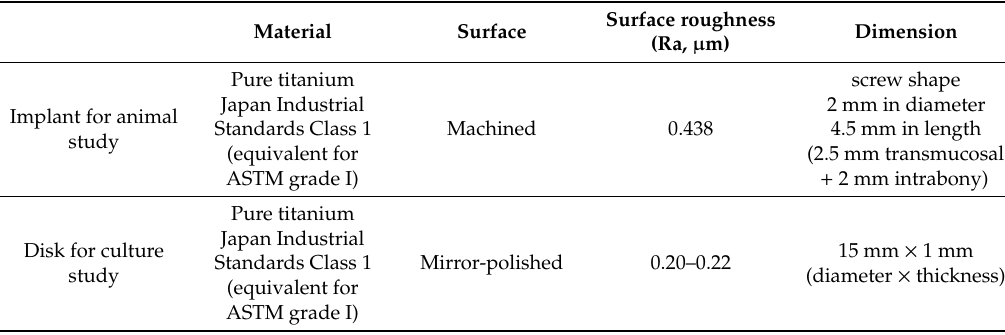
Table 1. Characteristics of culture disks and experimental